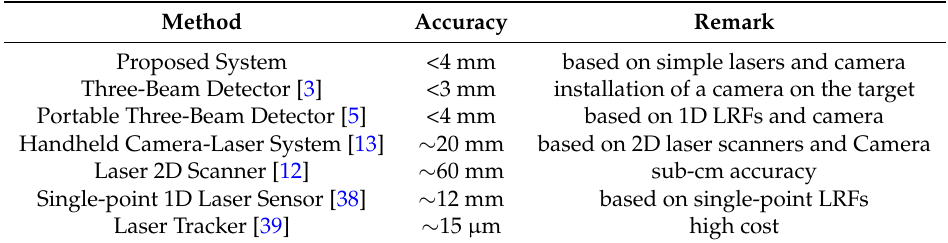
Table 2. Comparison of multi-DOF sensors for measurement